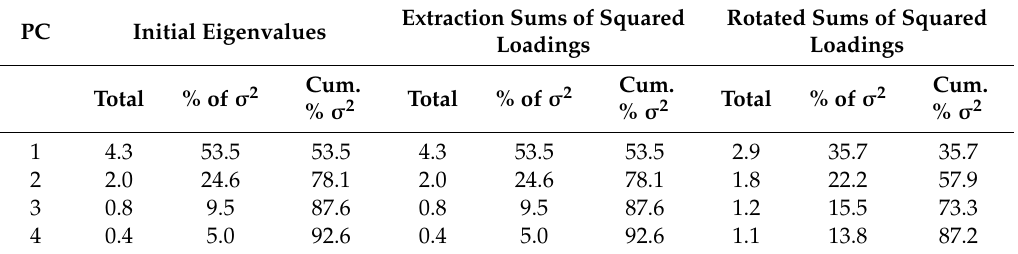
Extraction Method: Principal Component Analysis. Rotation Method: Varimax with Kaiser normalization. Rotation converged in 6 iterations. Kaiser-Meyer-Olkin (KMO) Measure of Sampling Adequacy (MSA) = 0.797. Bartlett’s Test of sphericity: χ 2 = 1015.83, df = 28, p <